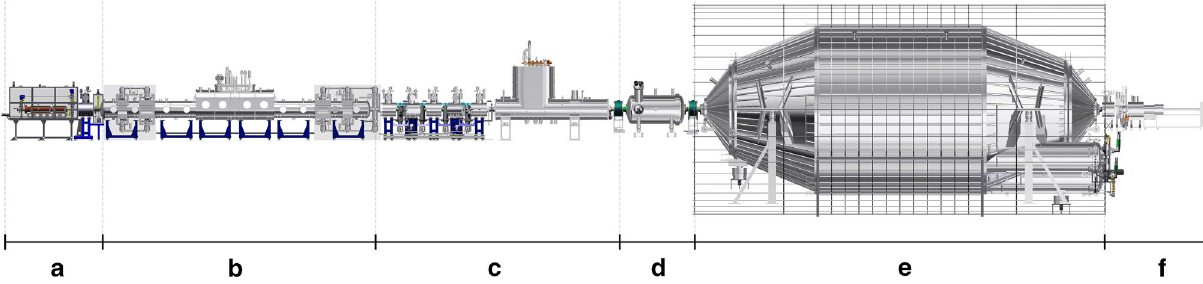
spectrometer section, which features two spectrometers operating as MAC-E-filters. The smaller pre-spectrometer (d) acts as a pre-filter for low energy electrons, and the larger main spectrometer (e) is used for the energy analysis in the endpoint region. A segmented detector (f) acts as a counter for the transmitted signal